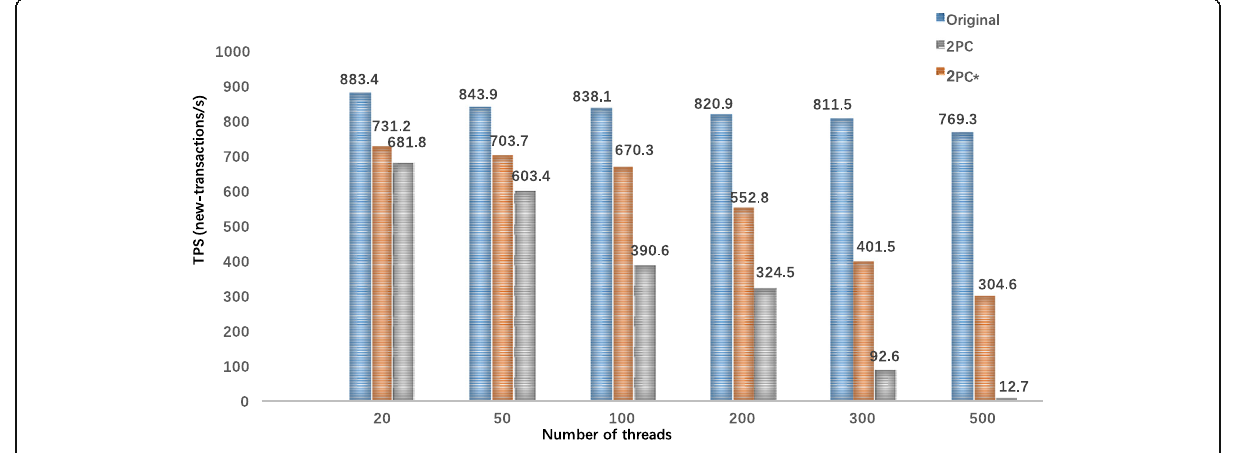
Fig. 8 TPS experiment